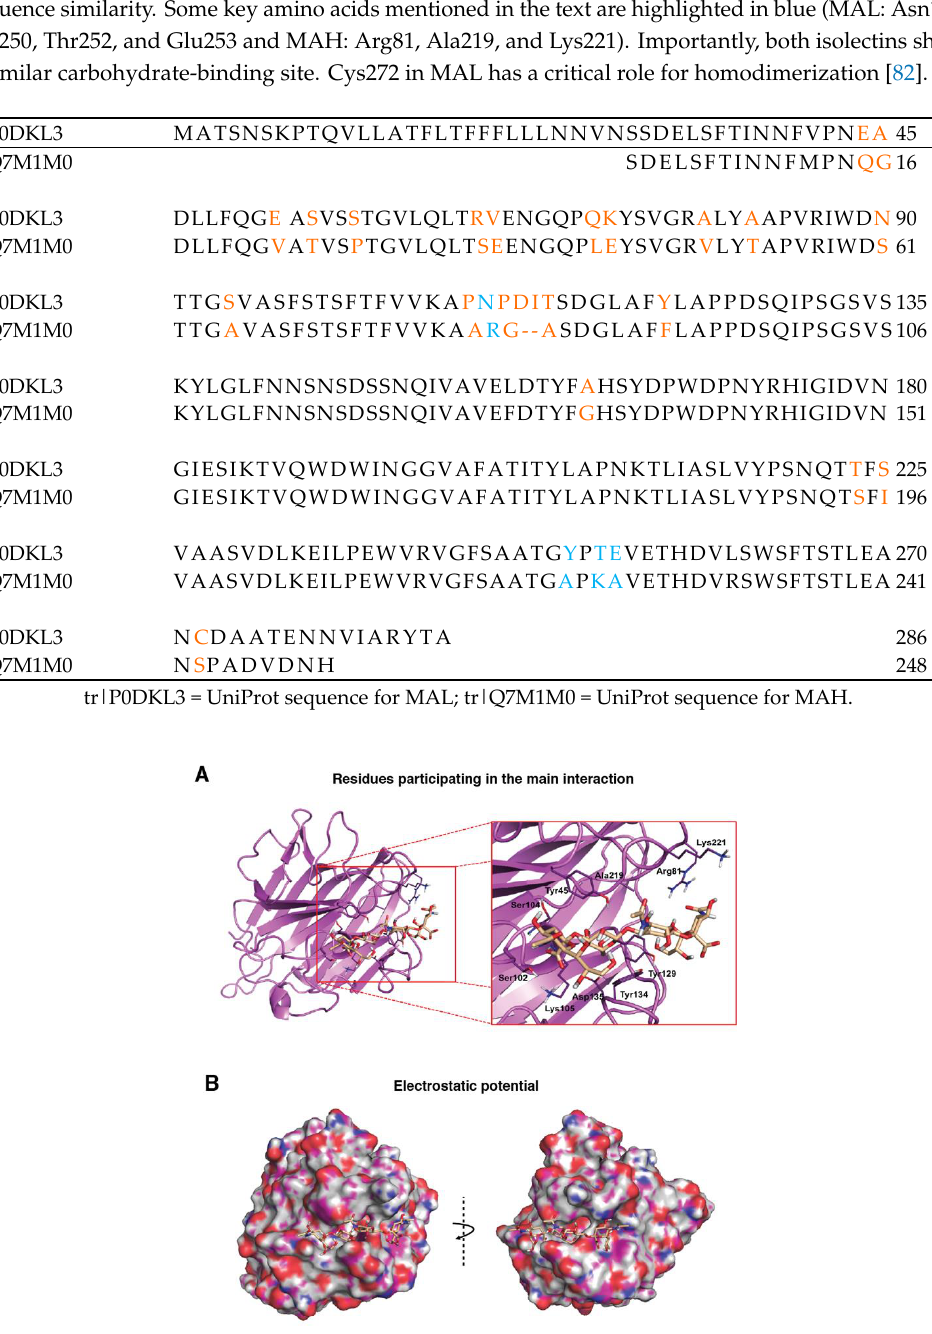
Table A1. Leucoagglutinin (MAL) and haemagglutinin (MAH) sequences alignment. The alignment between the MAL and MAH sequences has been performed with the T-Co ff ee web server [81]. The residue di ff erences between the two sequences have been highlighted in orange, indicating a high sequence similarity. Some key amino acids mentioned in the text are highlighted in blue (MAL: Asn110, Tyr250, Thr252, and Glu253 and MAH: Arg81, Ala219, and Lys221). Importantly, both isolectins share